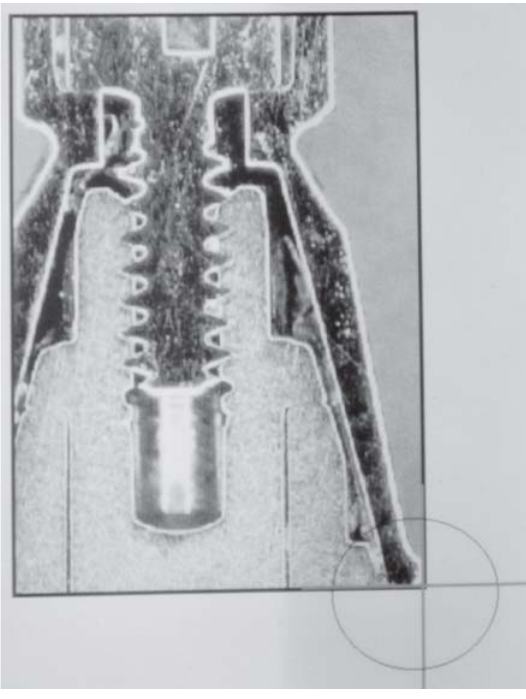
FIGURE 3B- Cross-sectional view of points for measurement